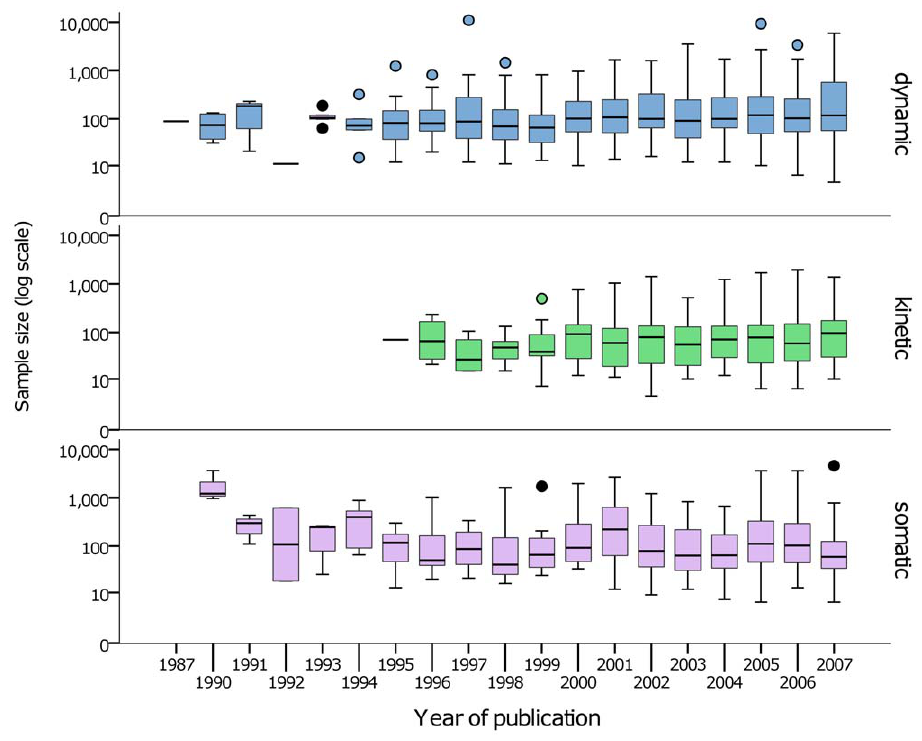
Figure 5. Sample size of pharmacogenetic studies from 1987 to 2007 (inclusive). Horizontal bars designate the median, boxes indicate 25 th and 75 th centiles of the distribution and vertical bars represent the non-outlier range.